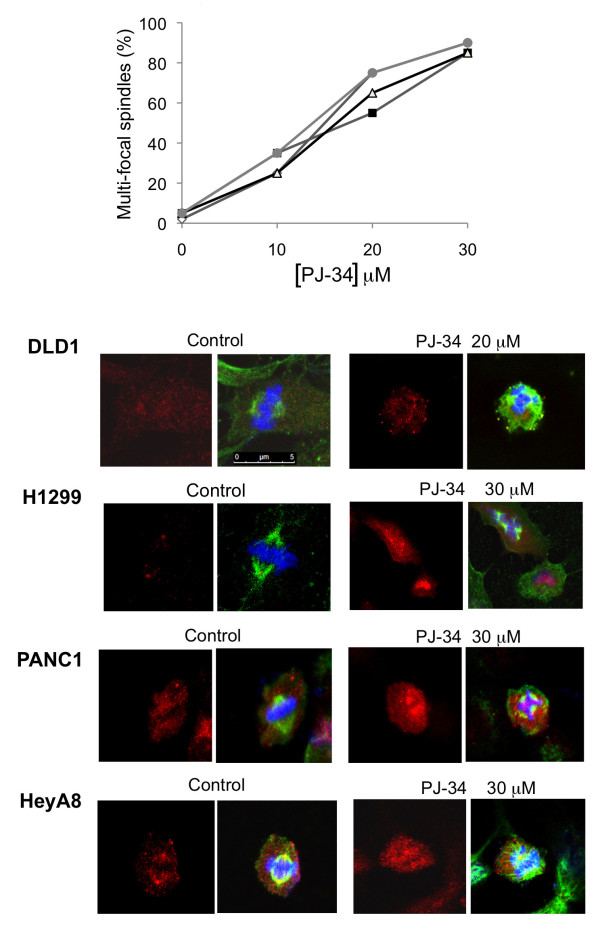
The phenanthridine PJ-34 prevented bi-polar clustering of extra-centrosomes in the tested human cancer cells. Top: PJ-34 interfered with the bifocal clustering of centrosomes in the indicated human cancer cells (DLD1, grey line, solid grey dots; H1299, grey line, empty diamonds; HeyA8, grey line, solid black squares; PANC1, black line, empty triangles) fixed 72 hours after application of PJ-34 at the indicated concentrations. Control and treated cells were permeabilized and immunolabeled for α- and γ-tubulin, for the detection of spindles (green) and centrosomes (red), respectively, as described below. The percentage of multi-focal spindles was calculated out of 20 spindles detected in randomly selected fixed cells by confocal microscopy in 3 different experiments. Bottom: Confocal images indicate scattered centrosomes and multi-focal spindles in randomly selected fixed cells in mitosis of the indicated cell-lines, 48 hours after application of PJ-34 at the indicated concentrations. Control (untreated) and treated cells were permeabilized and immunolabeled for α- and γ-tubulin (green and red, respectively). Chromosomes were labeled with DAPI reagent (blue).